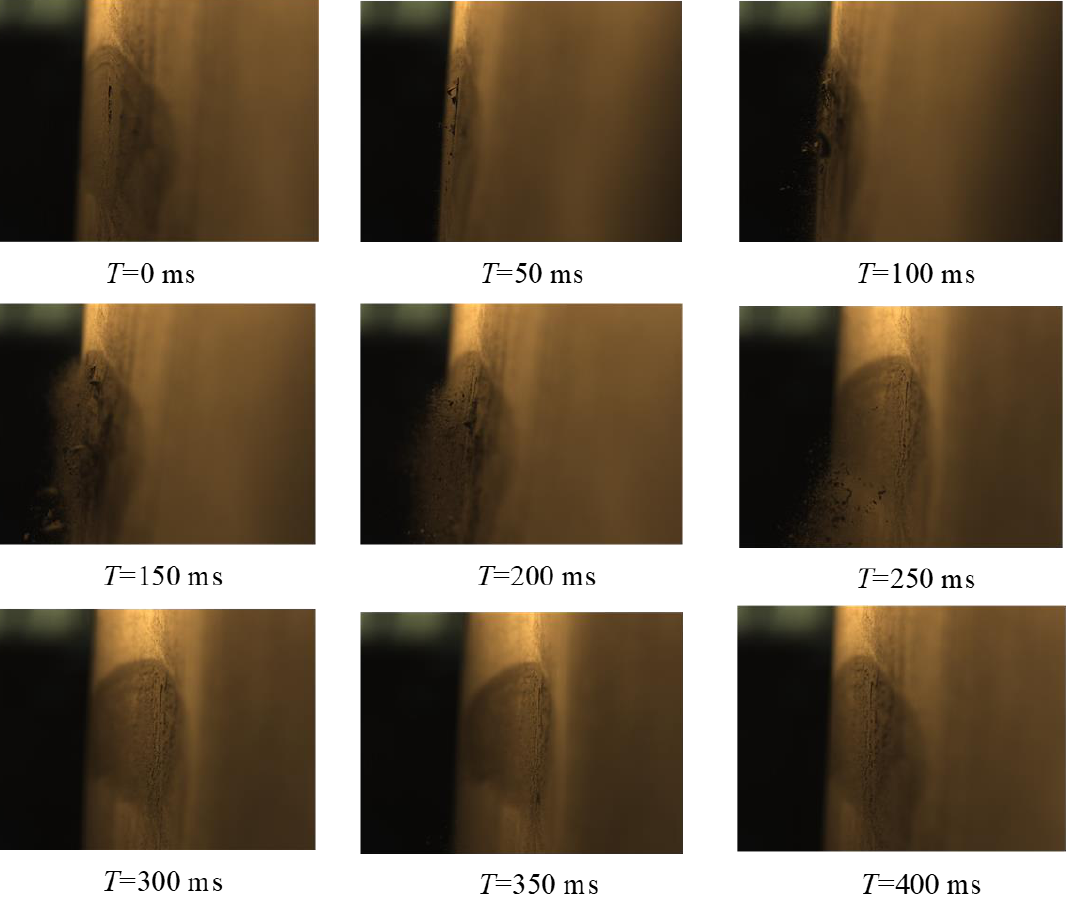
Figure 12. The peeling state of dust at different injection